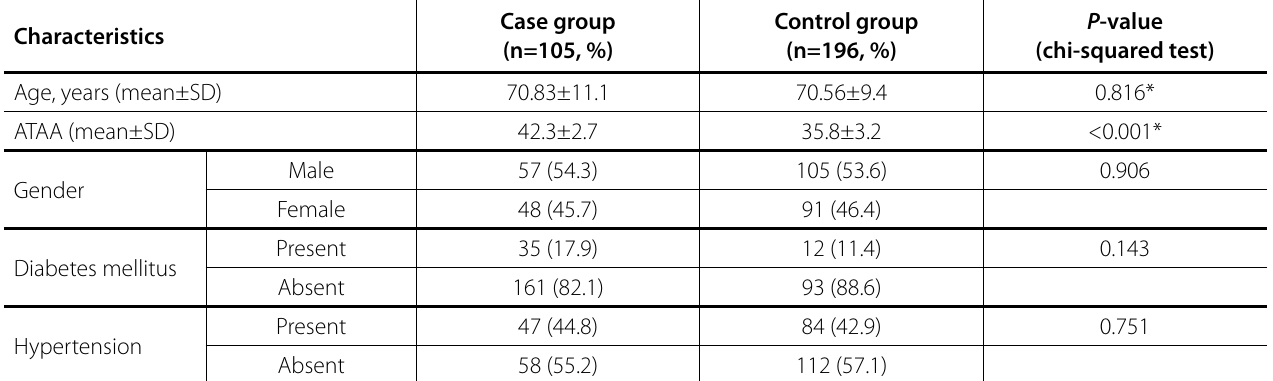
Table 1 . Demographic characteristics of the case group versus control group. Characteristics